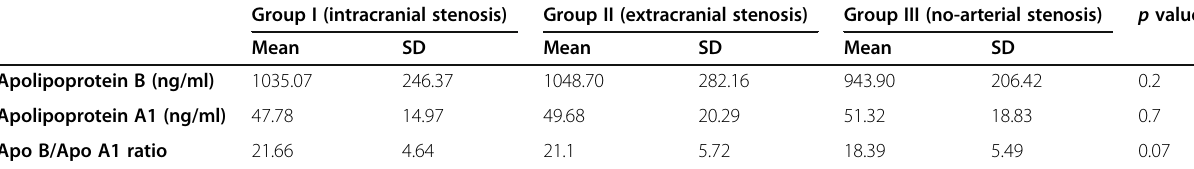
Table 3 Comparison of mean serum levels of apolipoproteins B, A1, and their ratio between patients groups